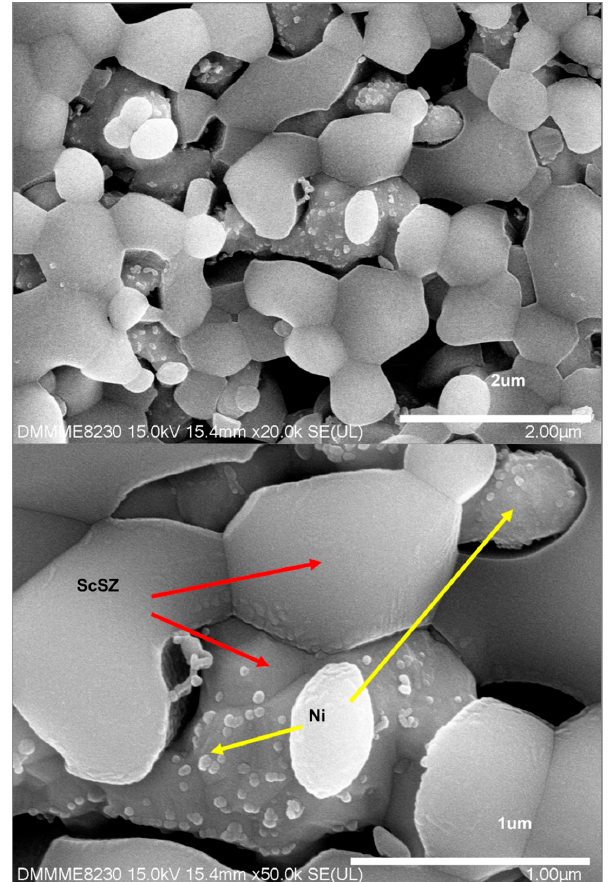
Figure 4. SEM images of reduced Ni/ScSZ (g/n = 0.27) at high magnifications with 20,000 × (top) and 50,000 × (bottom). Appl. Sci. 2018 , 8 , x